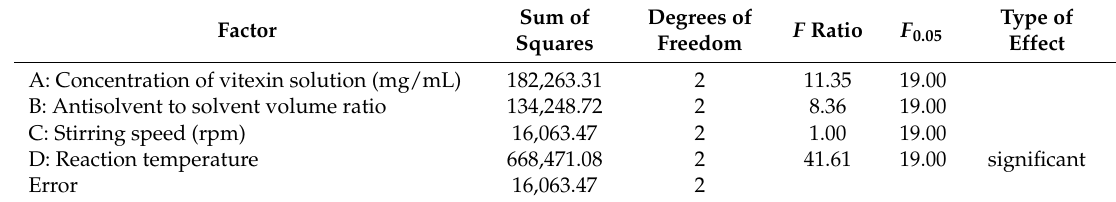
Table 2. ANOVA analysis of four factors for the ASP